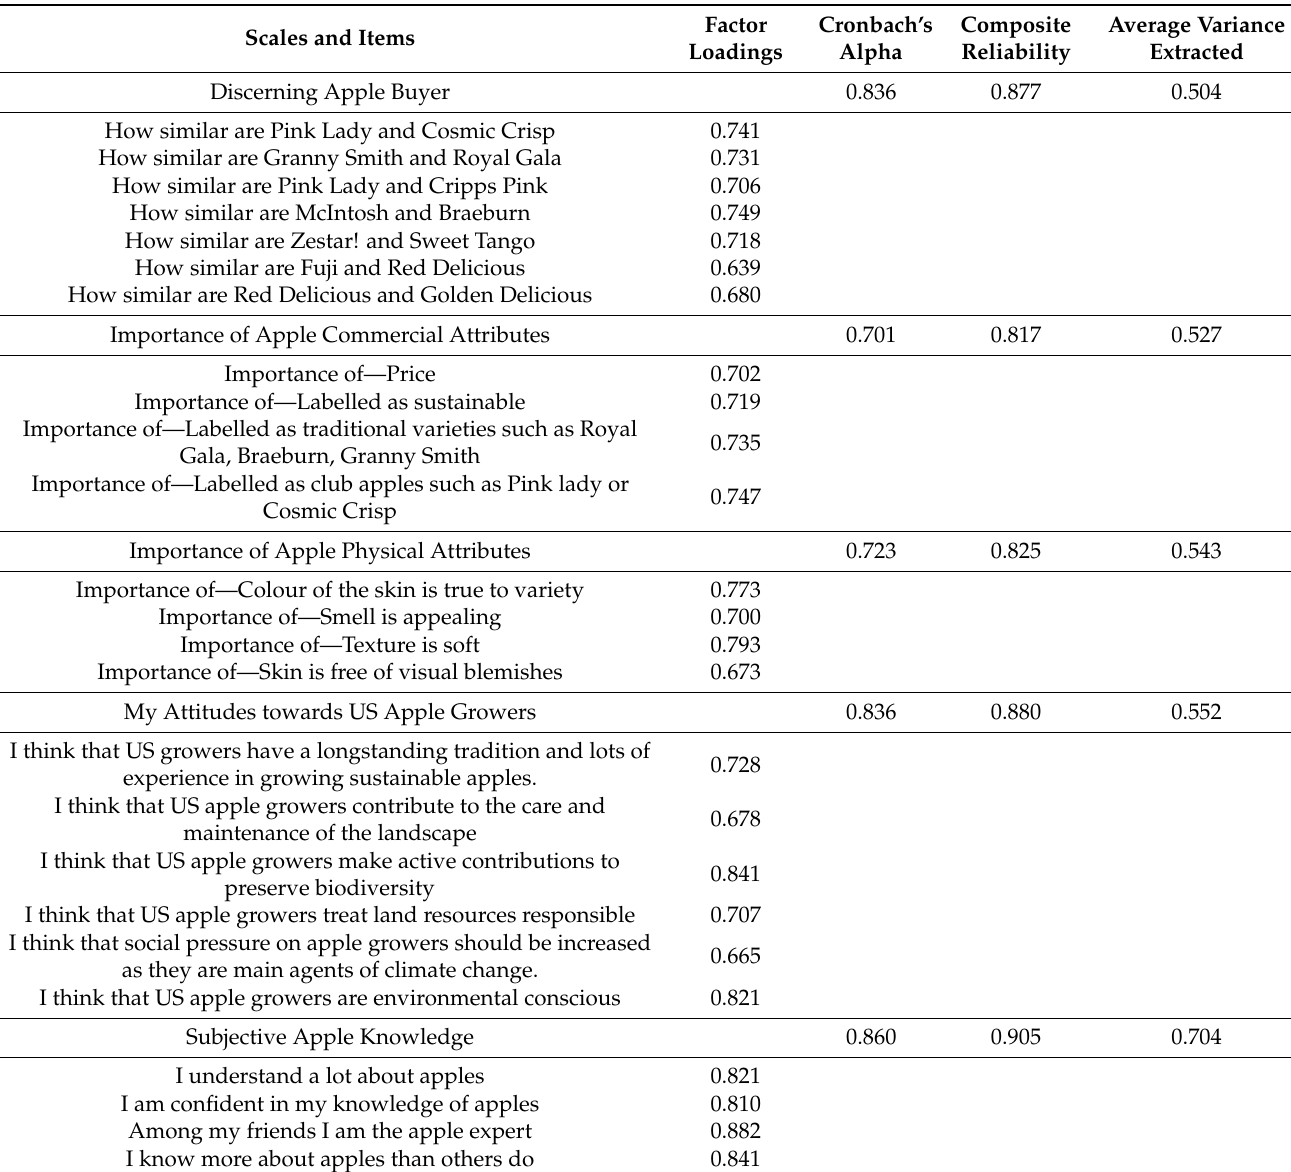
Table 2. Scale loadings, reliabilities, and convergent